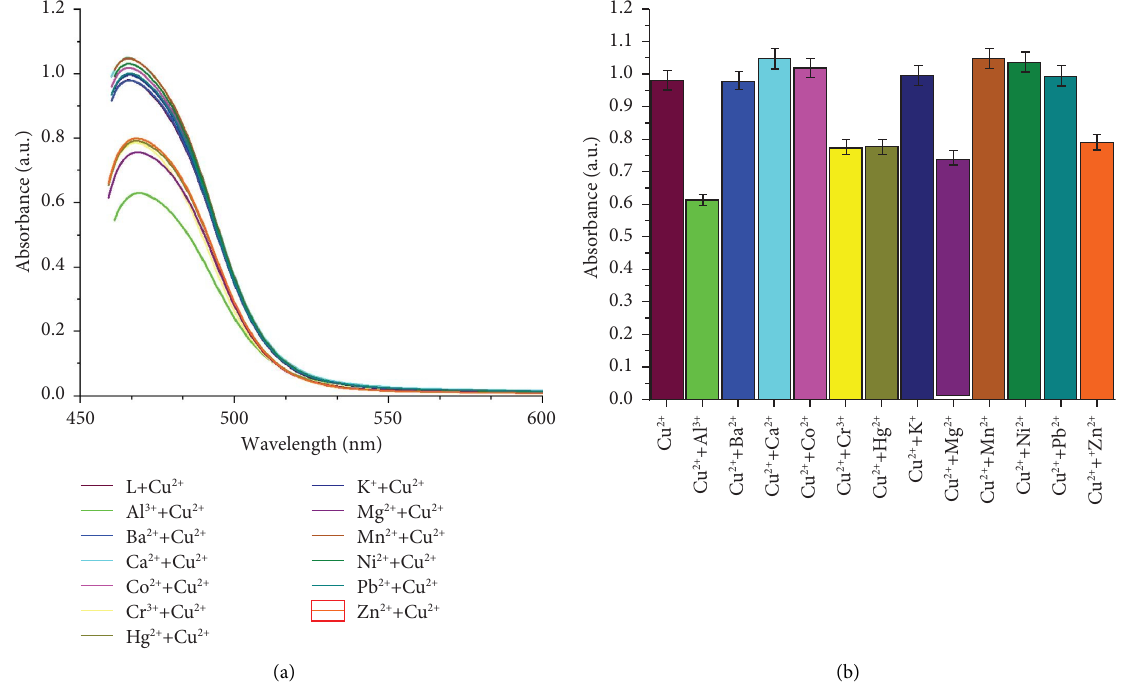
Figure 8: (a, b) Interference studies for the selectivity of the chemosensor SL towards Cu 2+ (70 μ M) in the coexistence of other cationic species (70 μ M).